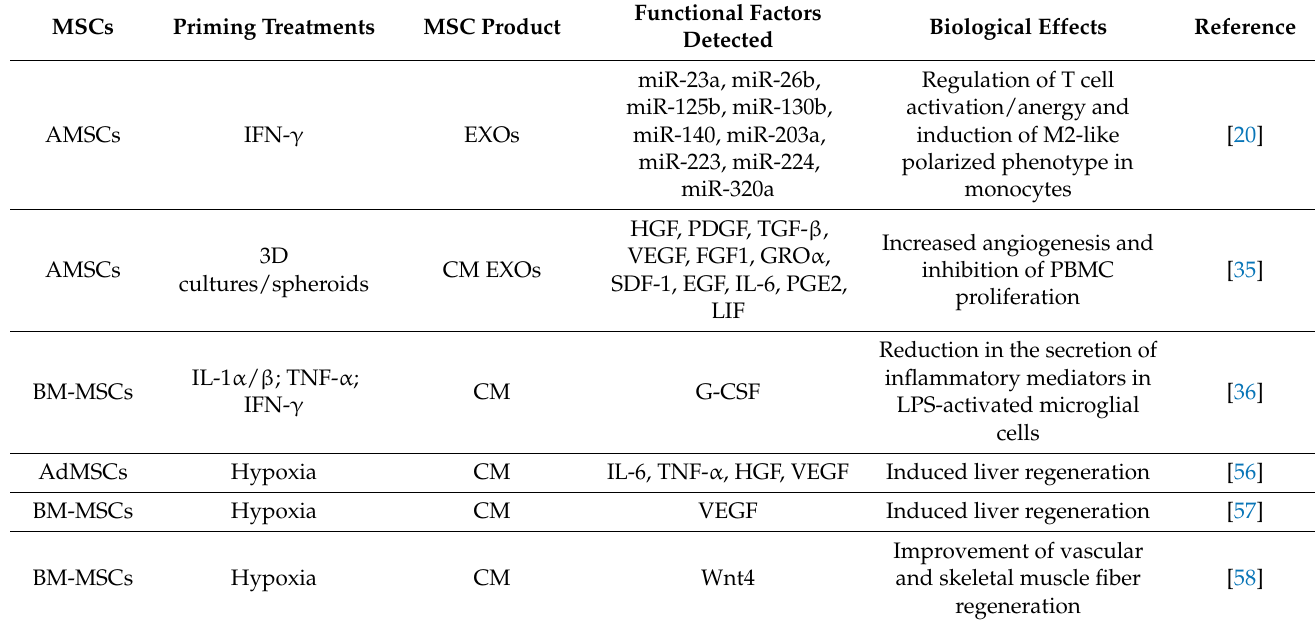
Table 1. Priming treatments of MSCs and production of therapeutic